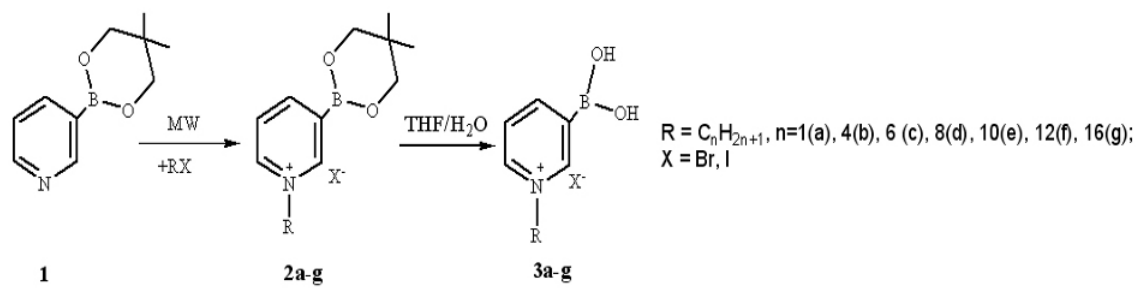
Figure 1. Scheme for N -alkyl-3-boronopyridinium halide preparation using microwave